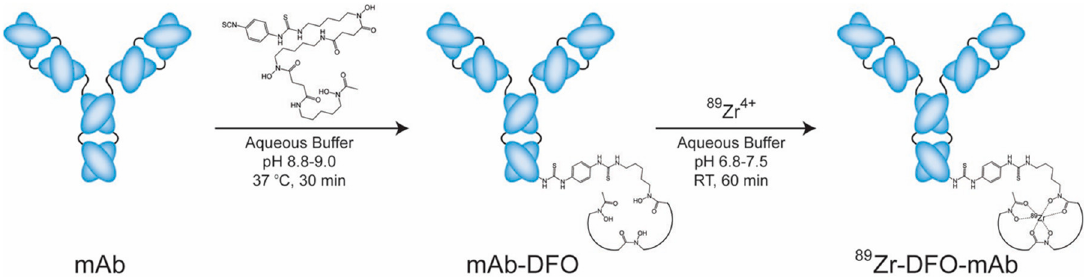
Figure 2. Scheme of the bioconjugation and radiolabeling of 89 Zr-desferrioxamine B (DFO)-J591. This is adapted from Zeglis, B. M., Lewis, J. S. The bioconjugation and radiosynthesis of 89 Zr-DFO-labeled antibodies. J. Vis. Exp. 2015 , 96 , e52521, doi:10.3791/52521.